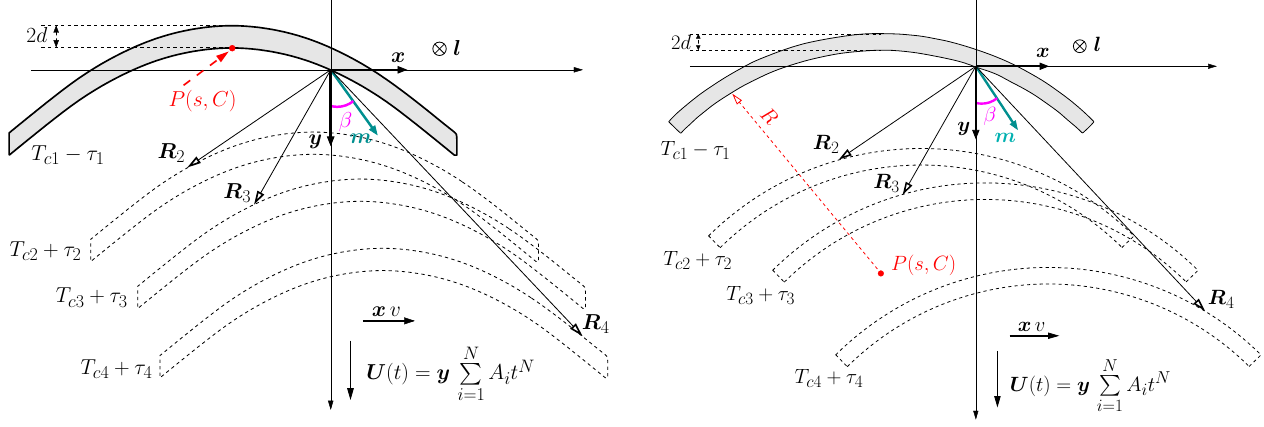
Fig. 7. Figure similar to Fig. 6 but corresponding to a cylindrical MP layer. Now the coordinates (s,C) indicate the MP center of curvature P at the initial time T c 1 − τ 1 . Details about the quantities shown in this figure are discussed in Appendix